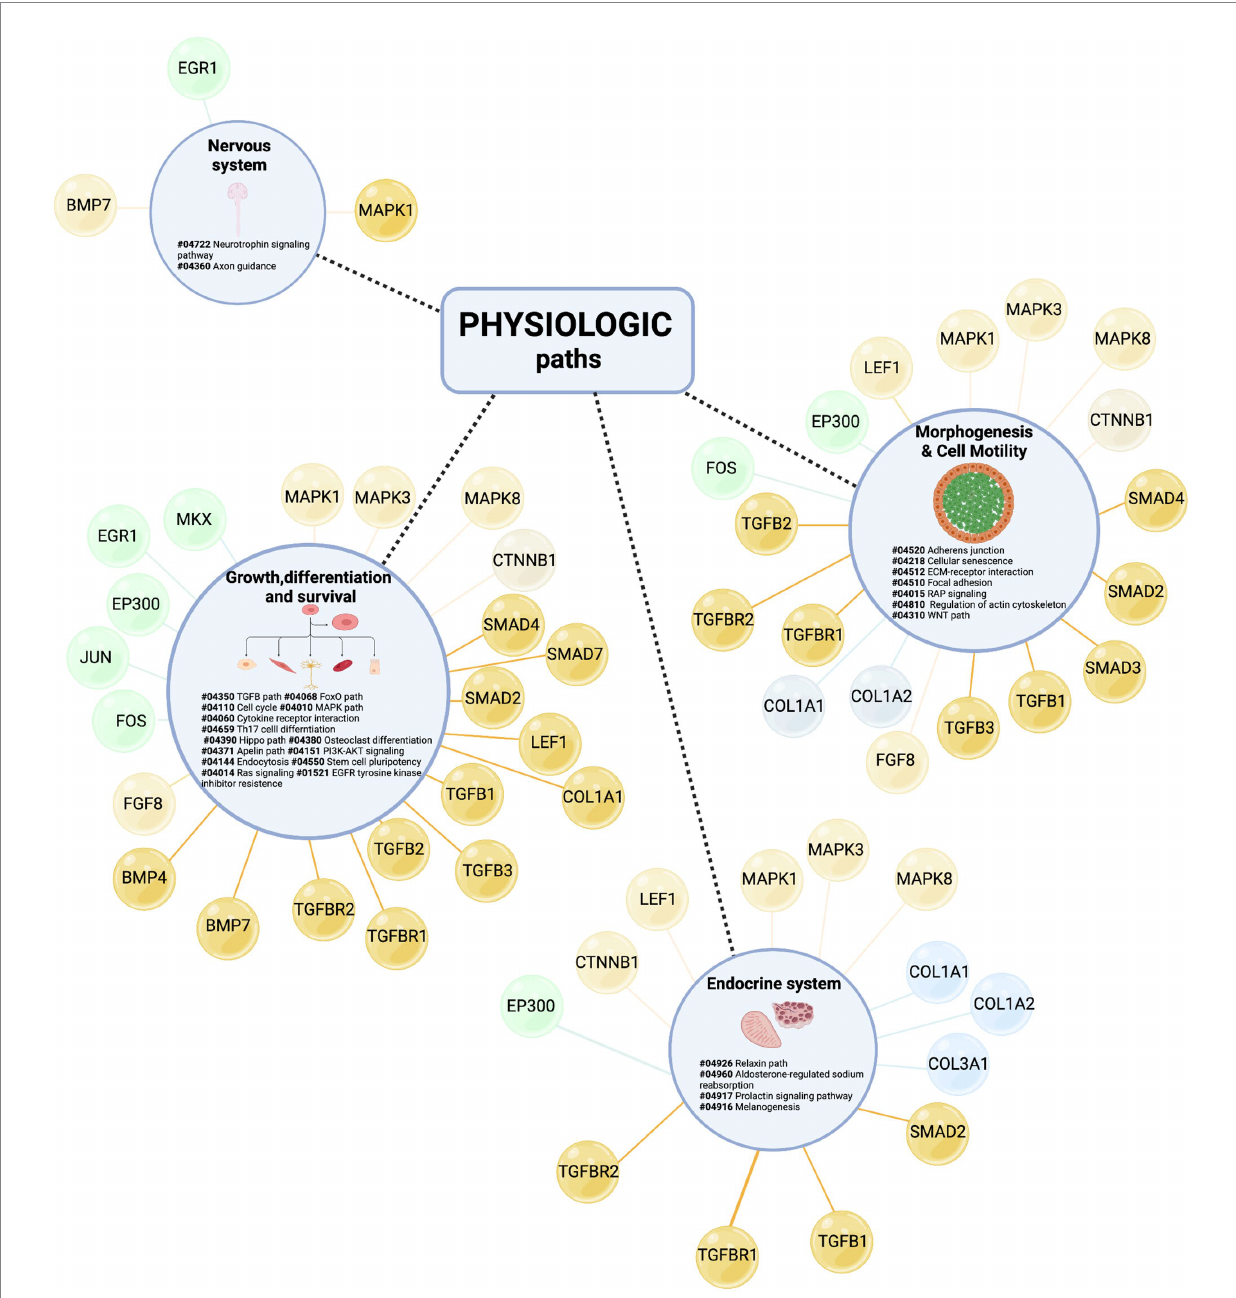
FIGURE 10 Identification of new paths sustaining tenogenesis signaling. Physiological-related BRITE macro-categories include (1) growth, differentiation, and survival, (2) morphogenesis and cell motility, (3) endocrine system, and (4) nervous system. For each macro-category, the internal KEGG paths were listed based on the number of sharing model organisms (from the most shared to the less one) and identified by specific numbers following the # sign. The different colors of the hub molecules allow to identify the signaling layer of pertinence. Yellow color indicates upstream molecules, green is TFs, and light blue is the downstream effectors. Created with